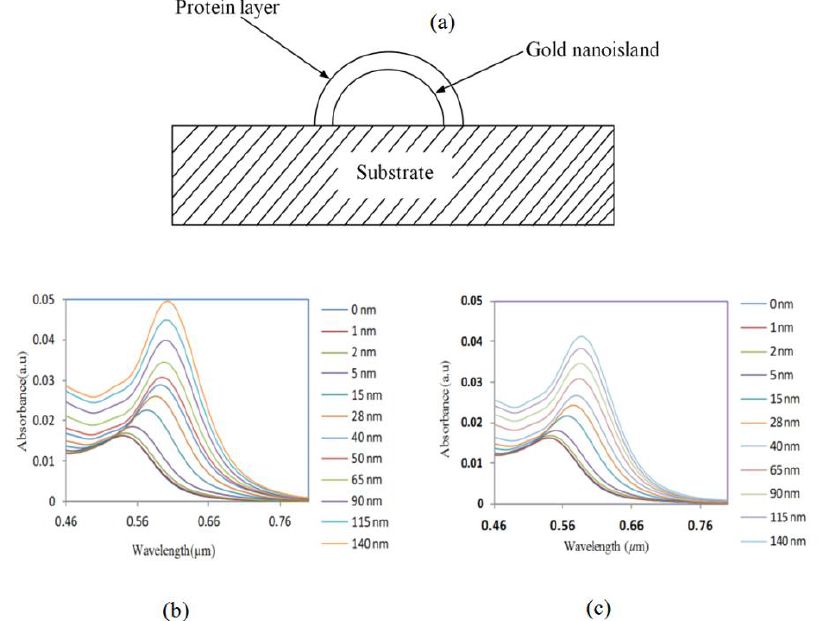
Figure 6. ( a ) Schematic of biosensor with gold hemispheres and a protein layer, change of LSPR spectrum against the thickness of the protein layer with a refractive index of ( b ) 1.5 and ( c )